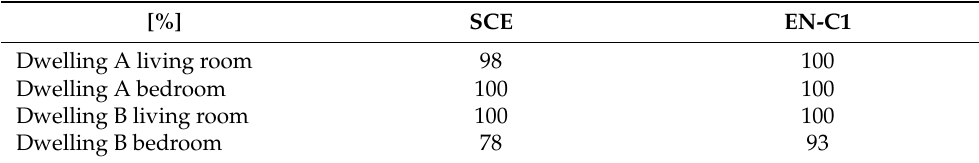
Table 7. Percentage of time when discomfort was